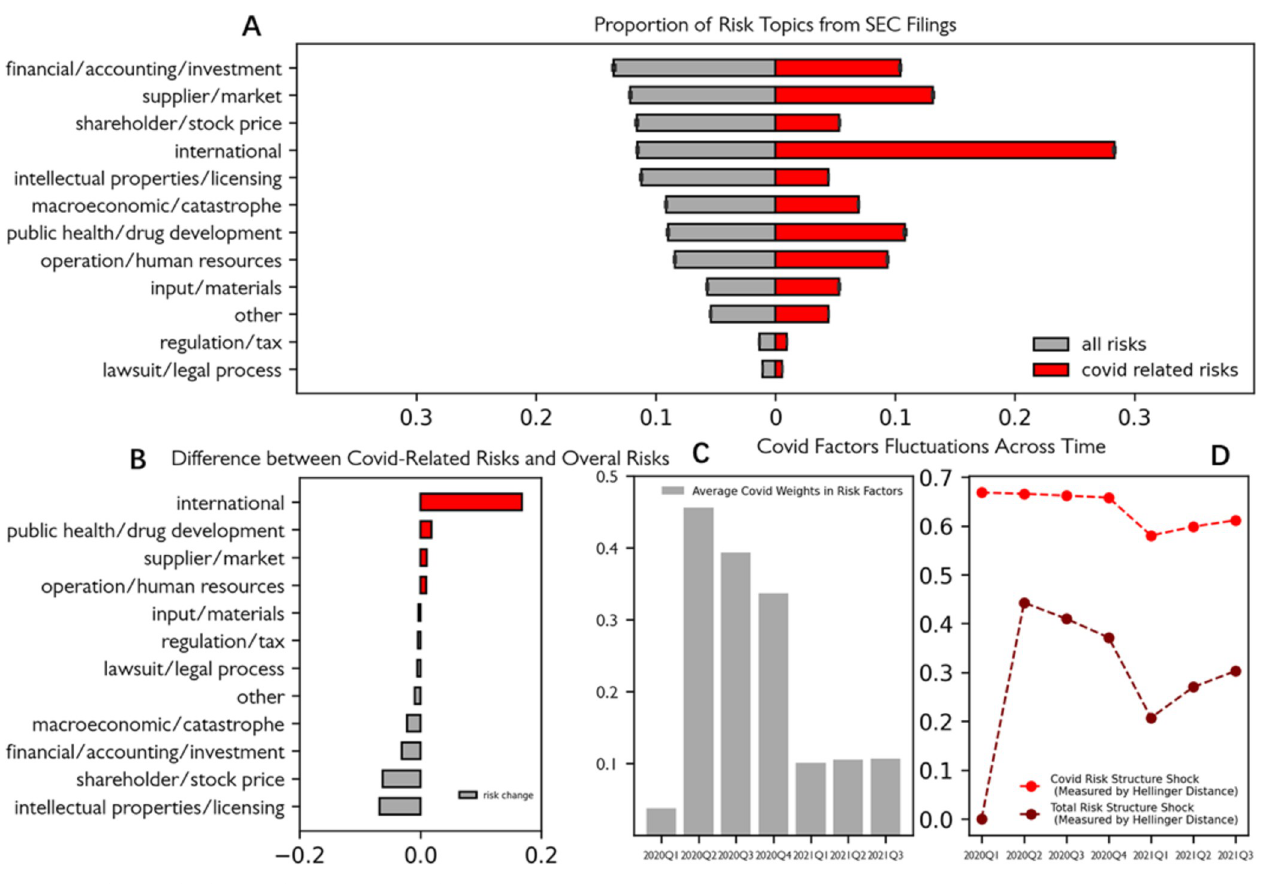
Fig 3. Distribution of risk topics during 2020 Q1 and 2021